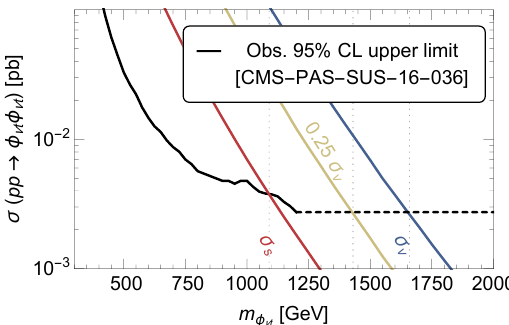
Figure 10 . Bounds on scalar and vector MLQs which decay into ( (cid:23)t )( (cid:23)t ) (cid:12)nal states. The observed 95% CL upper limit on the production cross section (black solid line) is taken from stop searches at CMS [21] which stopped at 1.2 TeV. Our analysis parallels that of (cid:12)gure 8.